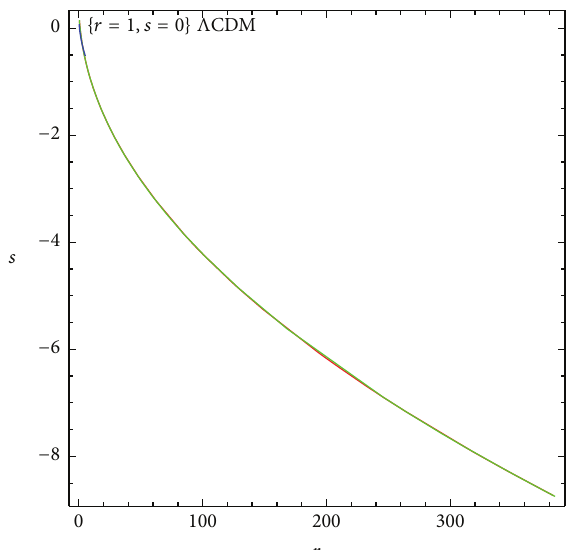
Figure 17: Plot of squared speed of sound for power-law form of 𝑓(𝑇) .